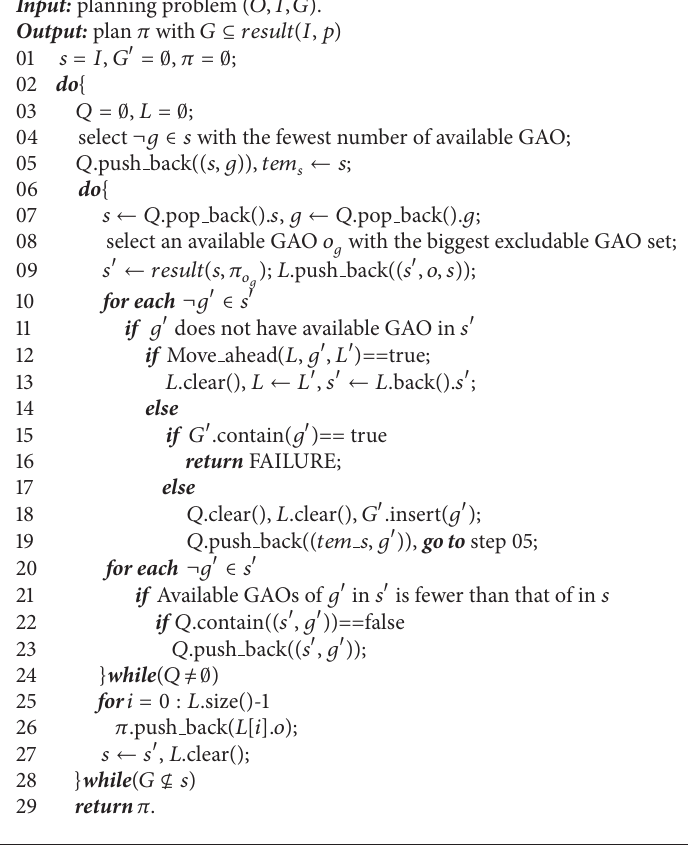
Algorithm 1: Ex MsFS